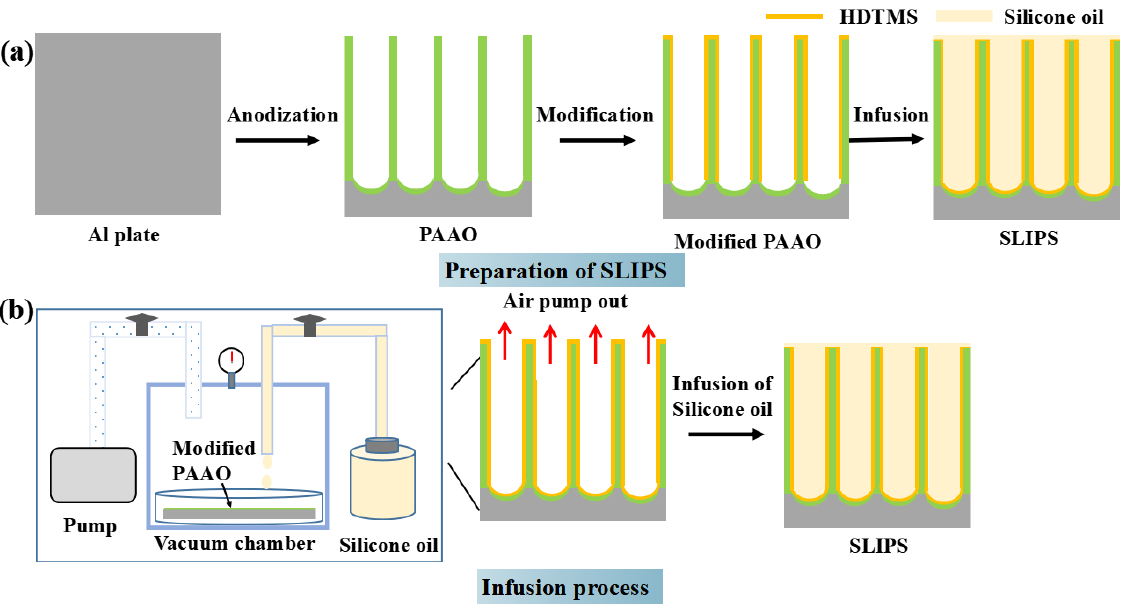
Figure 1. Process diagram for the fabrication of slippery liquid-infused porous surfaces (SLIPS) ( a ), the infusion device and the complete infusion process of silane oil ( b ).